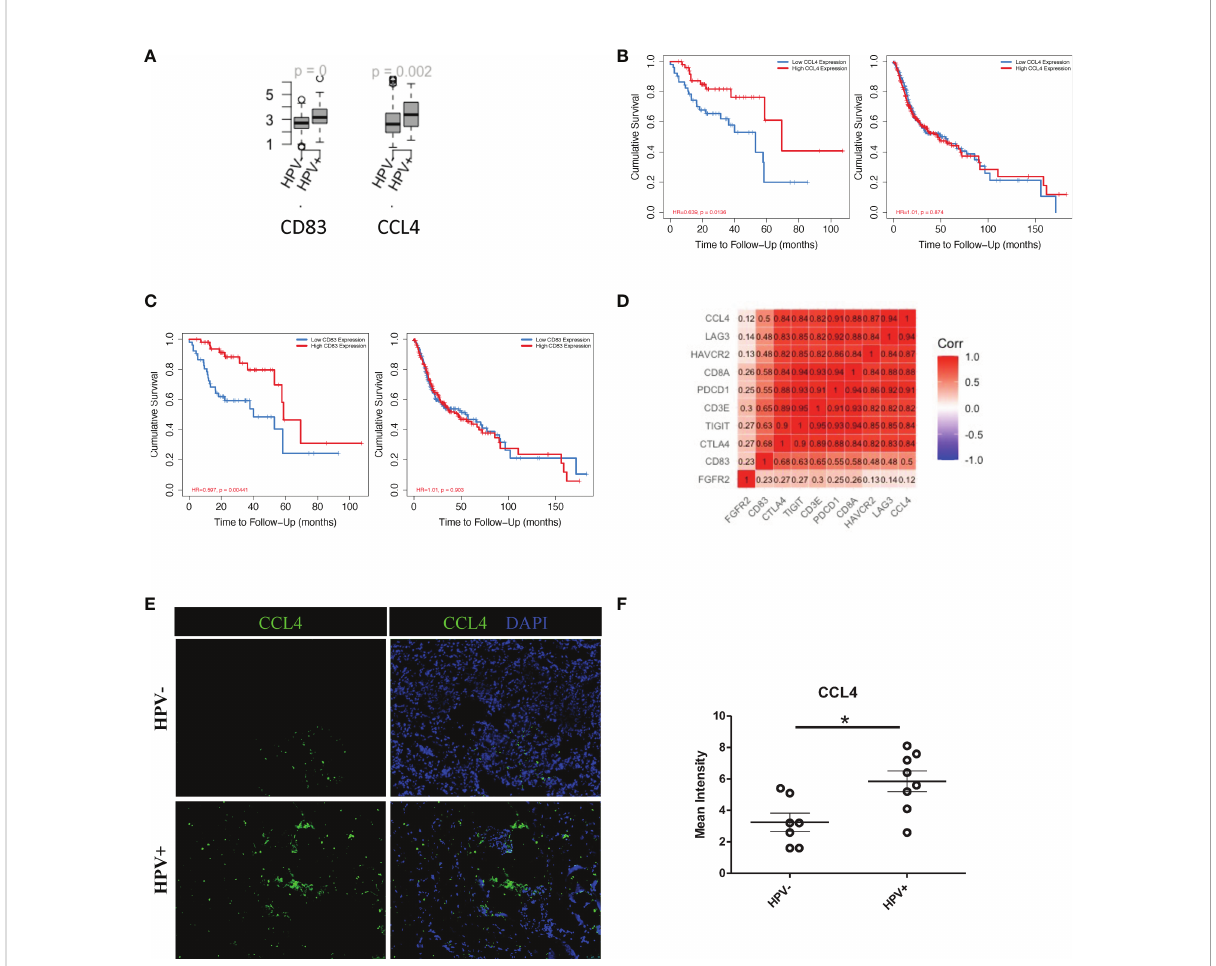
FIGURE 6 Cell communication between T cells and HPV + tumour cells. (A) Boxplots showing the gene expression of CCL4, CD83 and FGFR2 in the HPV + and HPV - HNSCC patients. p=0 refers to p<0.0001. (B) Kaplan-Meier survival analysis of CCL4 in the HPV + and HPV - HNSCC patients. (C) Kaplan-Meier survival analysis of CD83 in the HPV + and HPV - HNSCC patients. (D) A correlation plot showing the correlations between the expression levels of CCL4 and CD83 with those of the checkpoint related genes. (E) Representative immuno-stained photomicrographs of CCL4 in surgical sections obtained from patients with HPV + and HPV - HNSCC. (F) Dot plot showing the quanti fi cation of immunostainings. The data are means ± SD of 7 experiments and were analysed using Student ’ s t test;